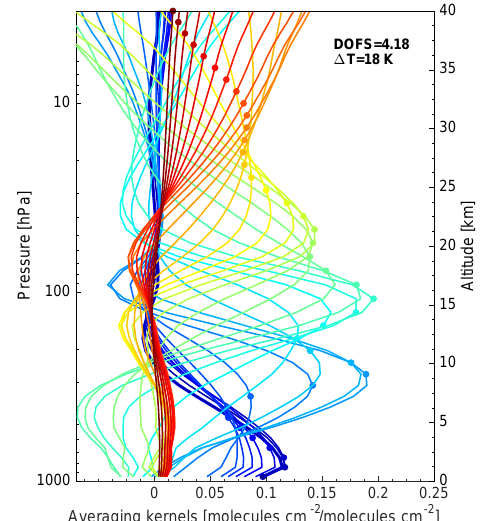
Figure 1. Example of IASI-A averaging kernel functions cor- responding to one daytime midlatitude measurement (31.3 ◦ N, 46.7 ◦ E) obtained on 15 July 2014 for each 1km retrieved layer from the surface to 40km altitude (color scale). The total DOFS and thermal contrast are also